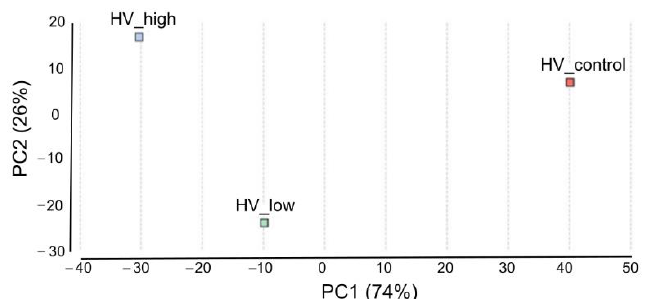
Figure 6. Principal Component Analysis of DEGs. Scatterplot of PC1 and PC2, explaining 74% and 26% of the variation, respectively, and separating the samples according to ELICE16INDURES treatment. The color of the data points indicates the treatments (red: control, blue: high dosage, and green: low dosage).